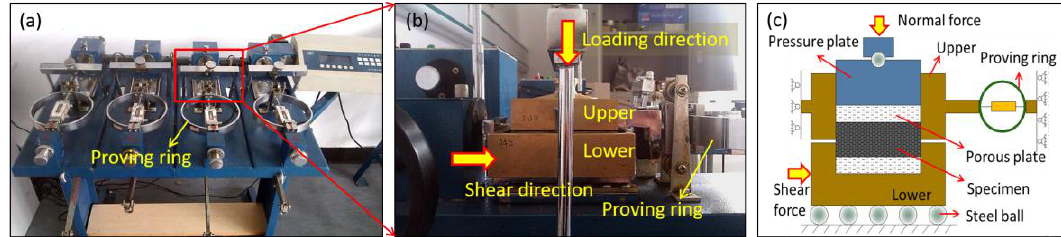
Figure 2. Test apparatus and methods. ( a ) Direct shear testing apparatus; ( b ) Shear vessel; ( c ) Schematic of the direct shear framework.